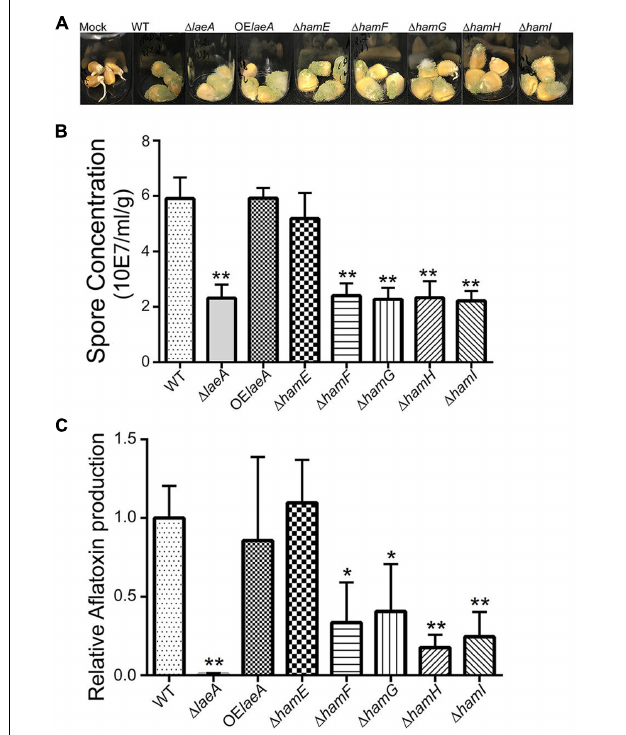
FIGURE 4 | Corn infection with ham mutants. (A) 200 µ l of 10 6 spore/ml suspension of spores in 0.01% Tween 20 were inoculated on corn and compared to a mock control of 200 µ l 0.01% Tween 20. The vials were kept in a moist chamber and placed in 29 ◦ C incubator with 12 h light/dark cycling and incubated for 5 days (Christensen et al., 2012). (B) The spores were washed off the seed with 3 ml 0.01% Tween 20 and counted. Each treatment was replicated three times. (C) Relative aflatoxin production of these mutants compared to WT (TXZ21.3.7). P -value, ∗ p < 0.05, ∗∗ p <